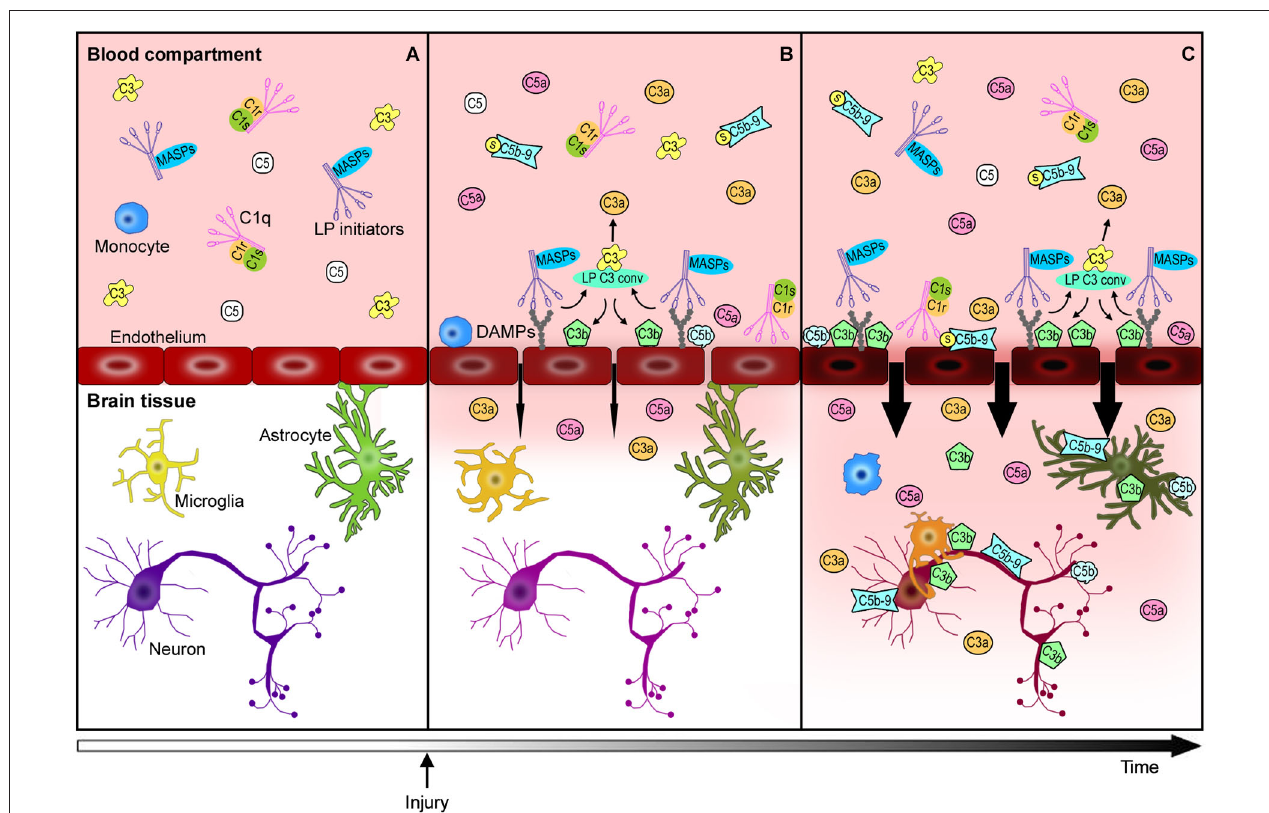
the BBB leakage ( B → C ). The injured brain parenchyma is then rapidly invaded by the full immune arsenal, including the complement proteins, cytokines and immune cells (e.g., monocytes) belonging to the blood compartment, leading to amplification of local damage (C) . The overactivation of the complement system in brain tissue leads to: (1) a potent inflammatory response and the recruitment of peripheral immune cells mediated by C3a and C5a anaphylatoxins, (2) direct lysis of neurons and other brain cells, including those that are potentially savable, by C5b-9, (3) opsonization with subsequent microglia/macrophage phagocytosis of the target cells by C3b and C5b. This schema proposes a key role for endothelial cells in triggering local LP complement activation and suggests that targeting the peripheral compartment may represent effective strategy for brain protection from injury and different acute CNS